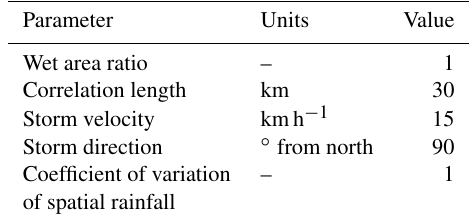
Table 2. Parameters of the stochastic rainfall generator